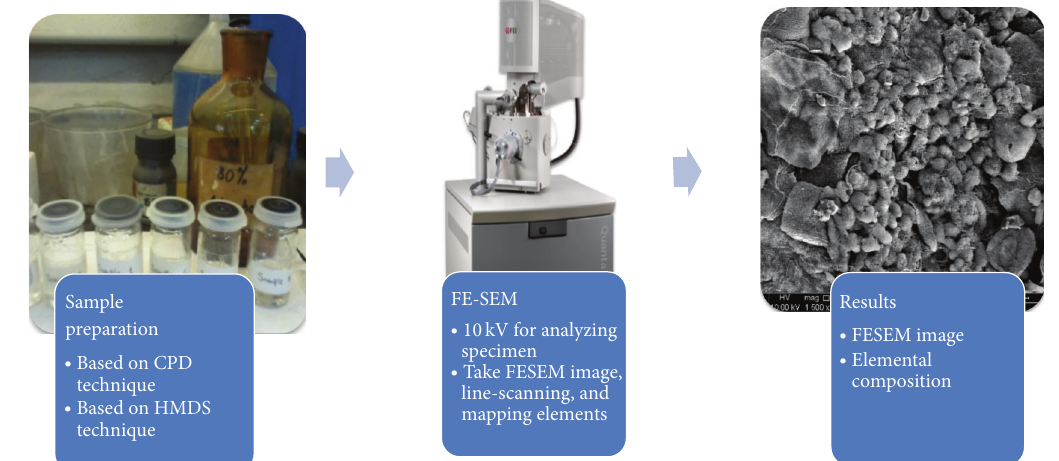
Figure 1: Overview of FE-SEM/EDX analysis.